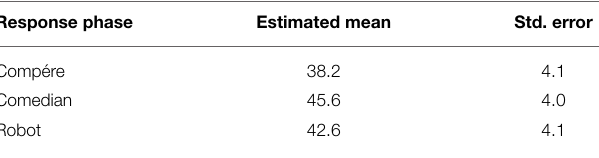
TABLE 4 | Estimated means and standard errors for “Happiness” response to each